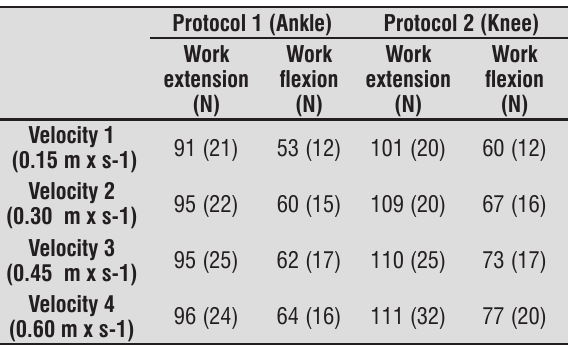
Table 2 - Descriptive statistics (mean ± SD) of the